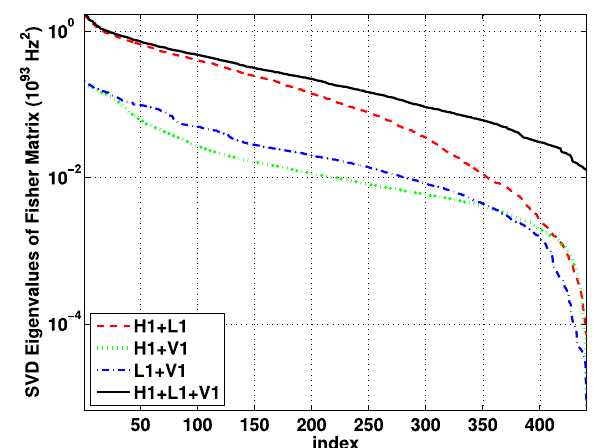
Fig. 50 Singular values of typical Fisher matrices F for different ground-based interferometer detector pairsandamultibaseline detector network.Forthisanalysisthere were 441total modes.Foreachindividual detectorpair,someofthesingularvaluesare(almost)null.Themultibaselinenetworkhasfewernullmodes, thus acting as a natural regularizer. Image reproduced with permission from Thrane et al. (2009), copyright by